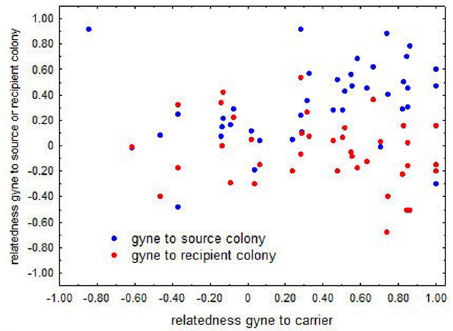
Fig. 4 Genetic relationship between carried gynes, the carrier, and source and recipient colonies. Association of the relatedness of gynes, which were carried by workers, to the source colony (blue) and to the recipient colony (red) with the relatedness between gyne and carrier ( n = 40 pairs of gyne and carrier).